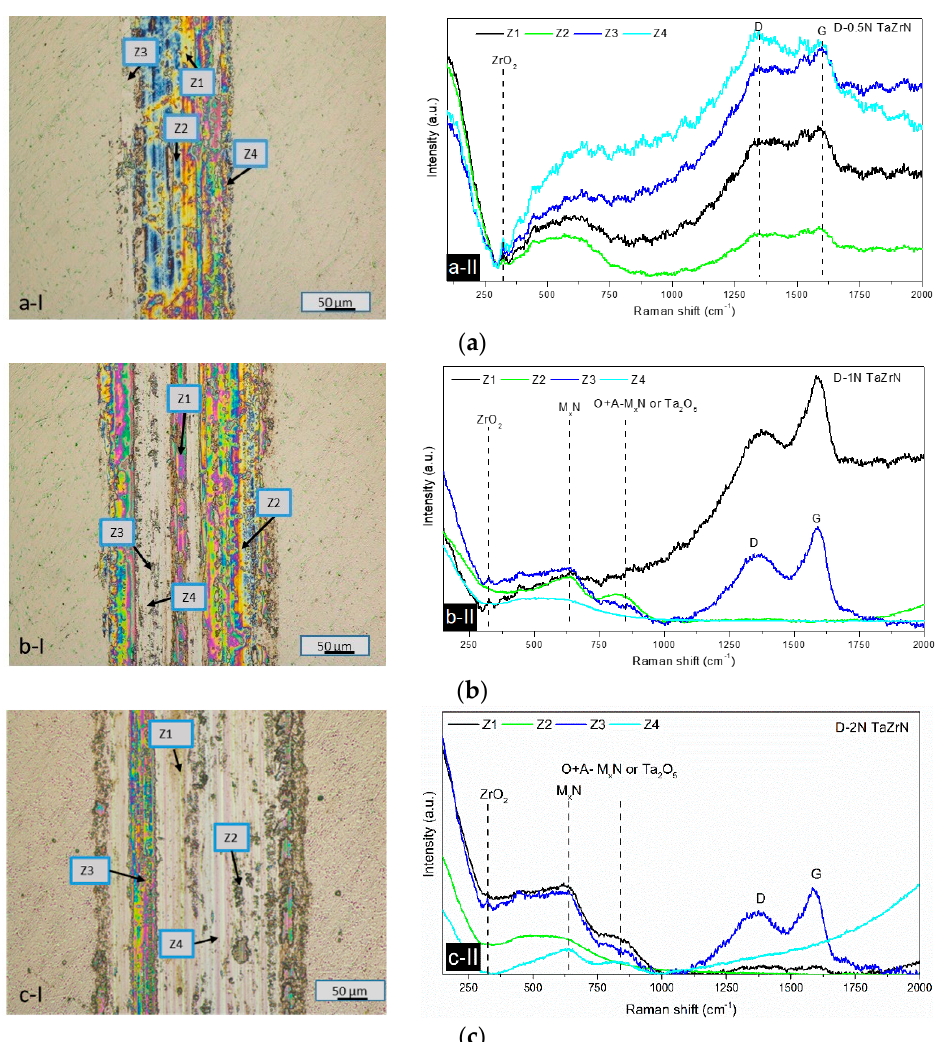
Figure 9. Results obtained in the tribological tests under dry conditions. ( a-I – c-I ) shows optical images of wear tracks from the test at 0.5 N, 1 N, and 2 N, respectively. ( a-II – c-II ) presents the Raman spectra of each point, labeled as Z1 to Z4.